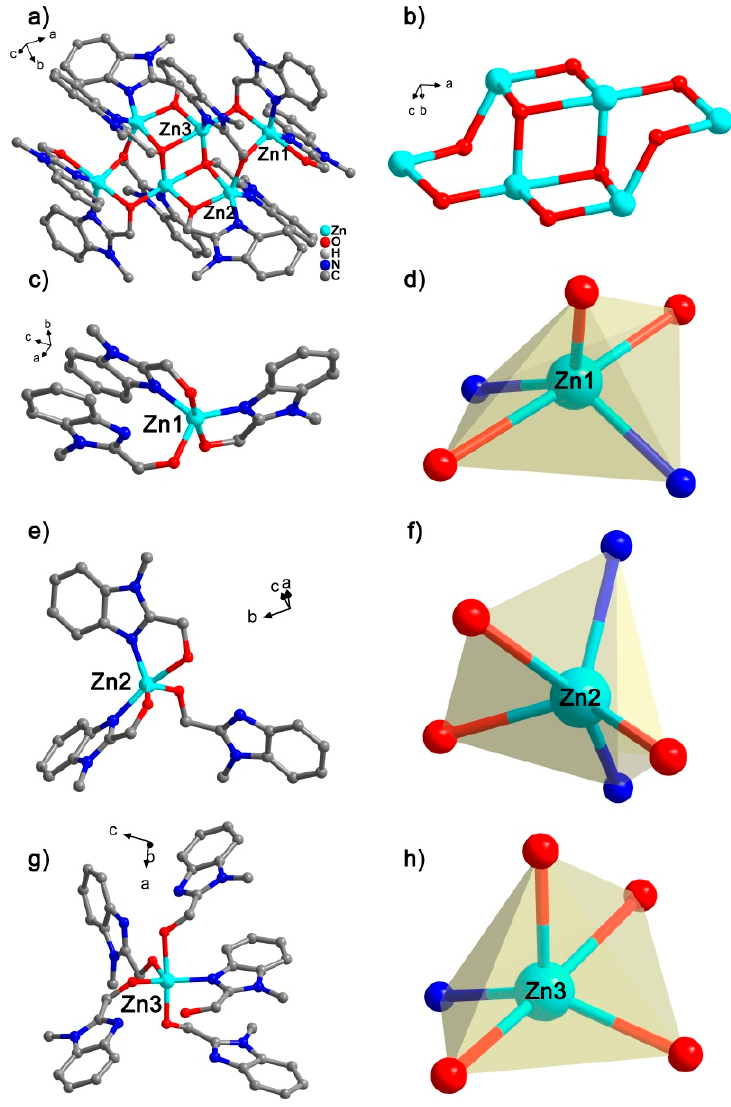
Figure 1. ( a ) Crystal structure of complex Zn6 ; ( b ) cluster nucleus Zn 6 O 8 structure, where all H, C, and N atoms are omitted for clarity; coordination environment ( c , e , g ) and coordination configuration ( d , f , h ) of Zn1, Zn2, and Zn3.